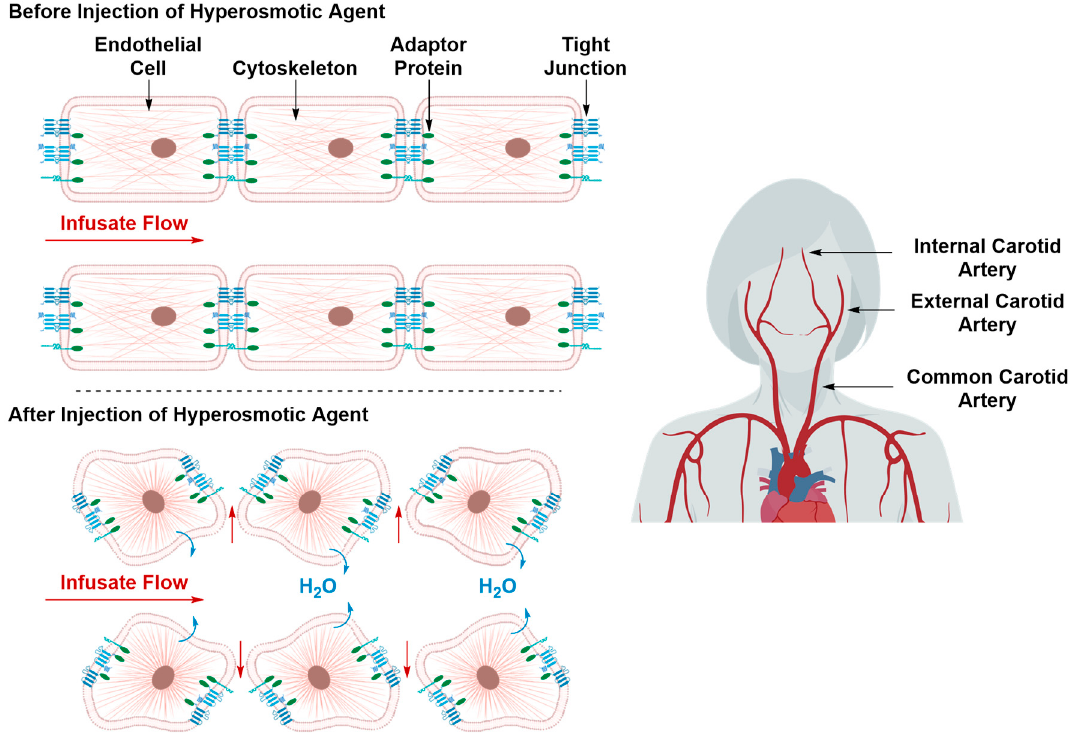
Figure 8. Transient BBB disruption by treatment with a hyperosmotic agent. The hyperosmotic solution, typically co-injected with the therapeutic material, causes water to be withdrawn out of the ECs, resulting in their shrinkage, contraction of their cytoskeleton and disruption of their TJs, allowing the paracellular diffusion of the co-administered therapeutic material.